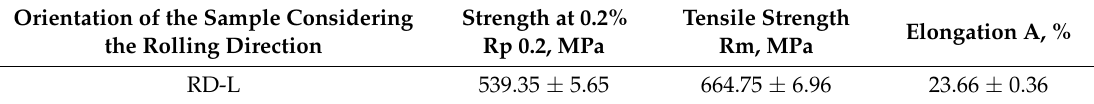
Table 4. Mechanical properties obtained from a tensile test at 21.5 ◦ C.